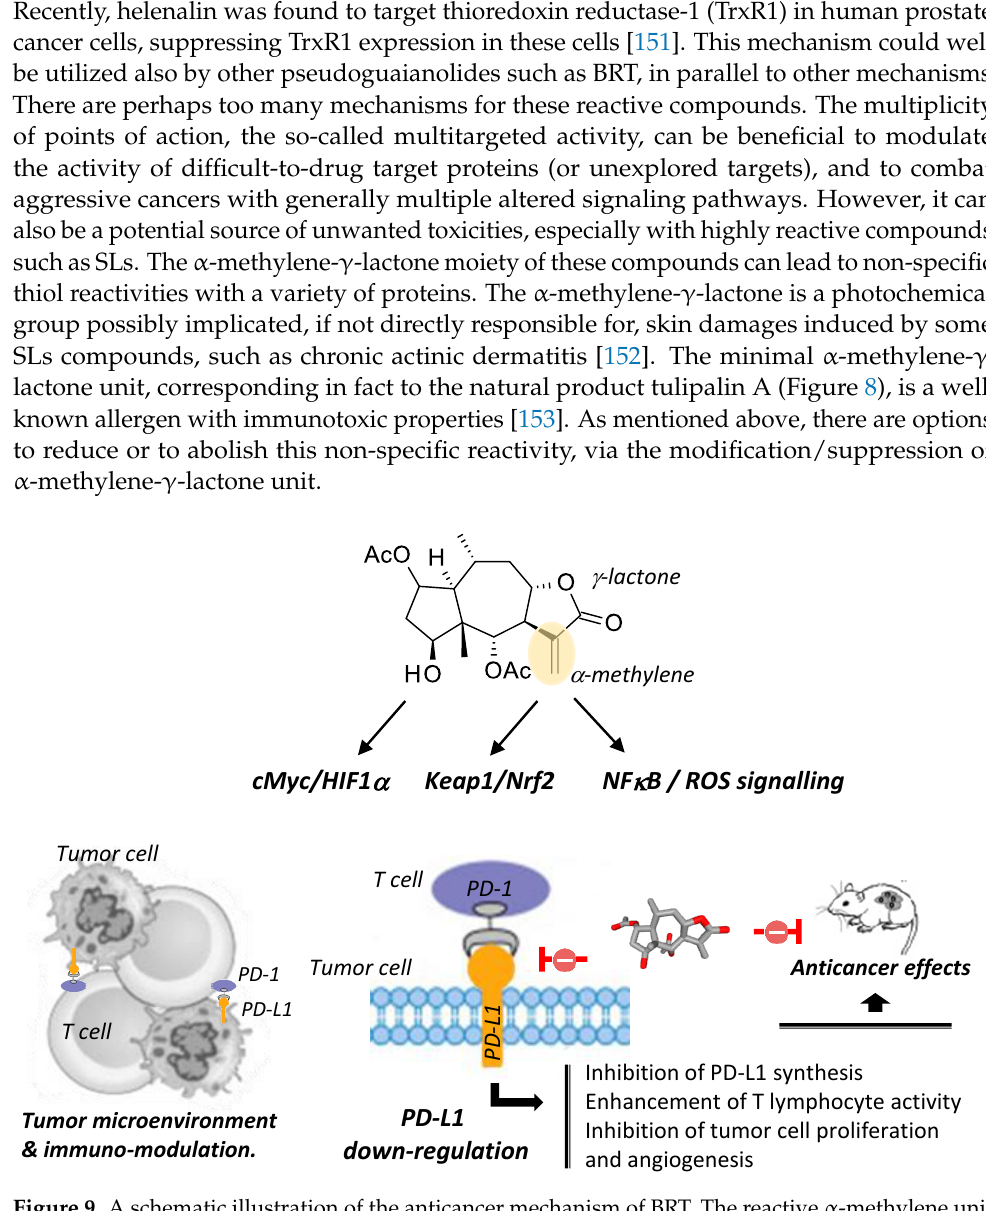
Figure 9. A schematic illustration of the anticancer mechanism of BRT. The reactive α -methylene unit of the compound plays a major role in inhibition of NF κ B and activation of Keap1/Nrf2 signaling. In addition, the compound induces a down-regulation of the membrane ligand PD-L1 expressed on cancer cells, thereby blocking the PD-1/PD-L1 immune checkpoint and activating cytotoxic T lymphocytes. Down-regulation of PD-L1 by BRT can occur directly via binding to PD-L1 and indirectly via repression of the cMyc/HIF1 α signaling route. Collectively, the effects lead to inhibition of cancer cell proliferation and